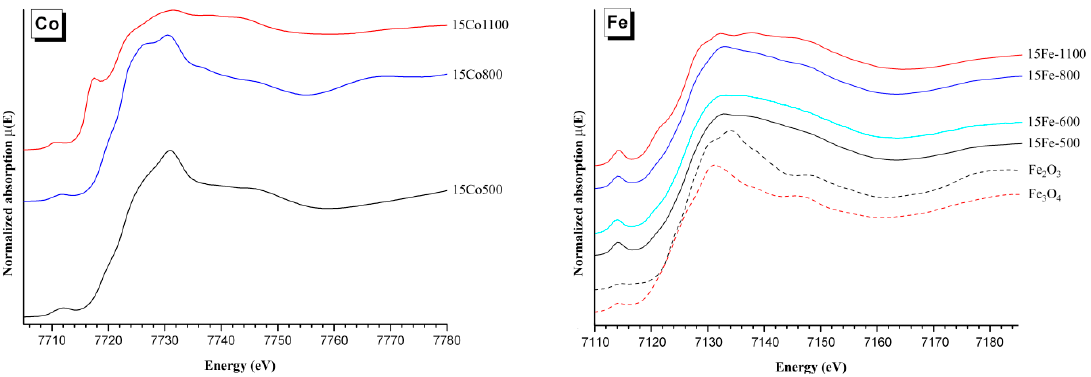
Figure 3. Normalized XANES spectra of the M K-edge for samples from the 15 M -T series and selected reference materials ( M = Zn, Cu, Ni, Co, and Fe).